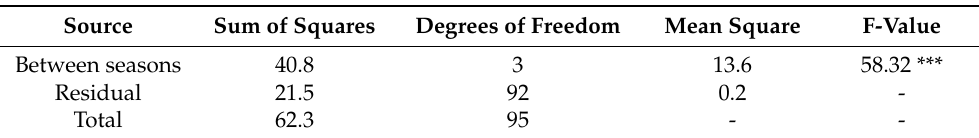
Table 5. Results of F-test for the seasonality in high-value species of sawlog price (price in